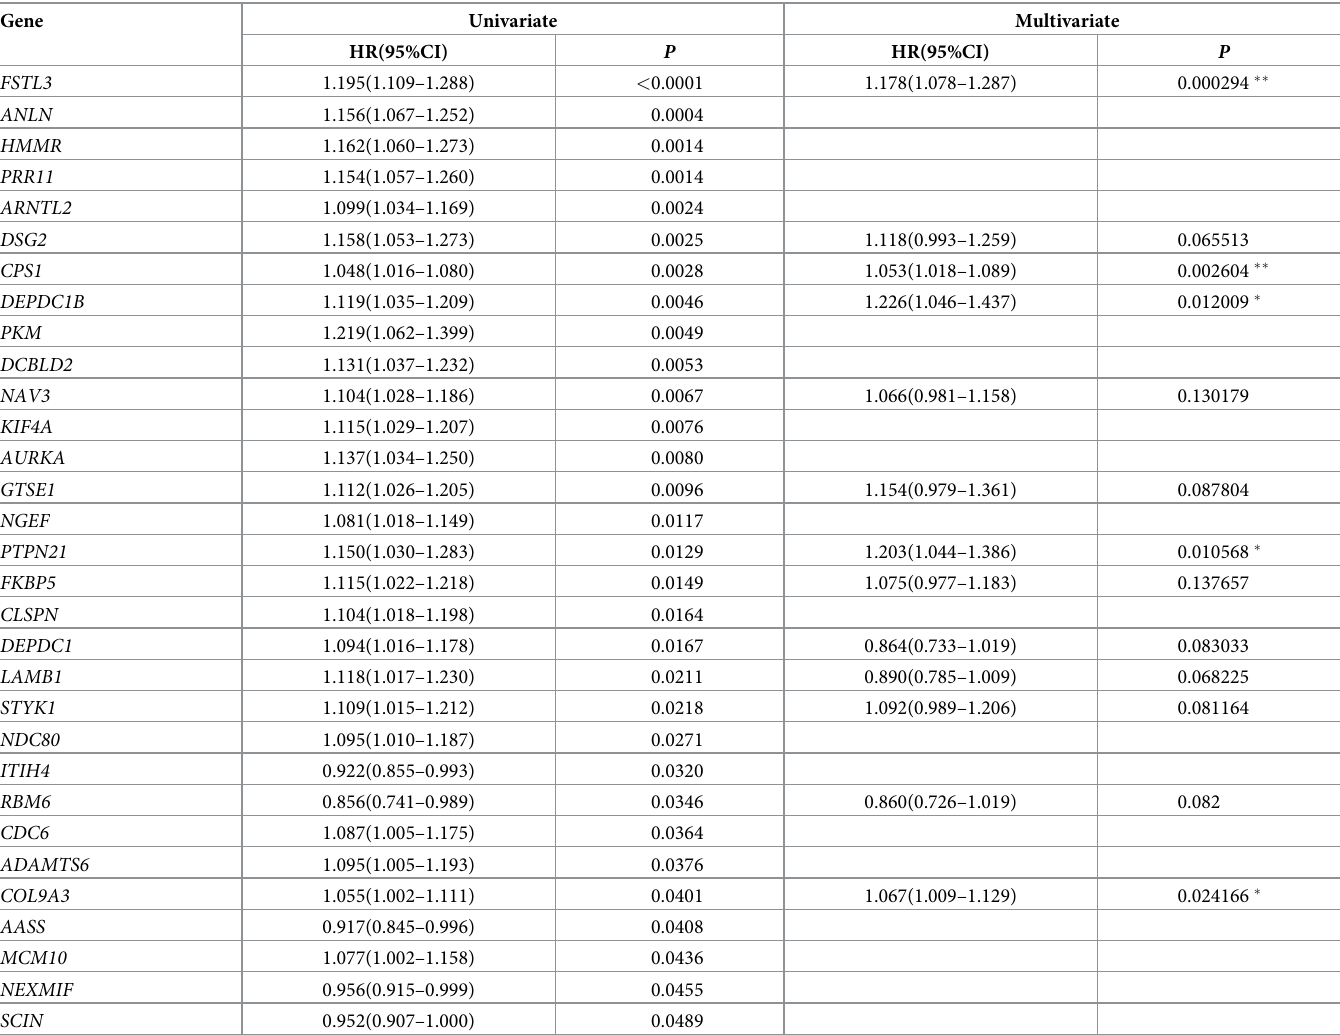
Table 2. Univariate and multivariate cox proportional hazard regression analysis of 31